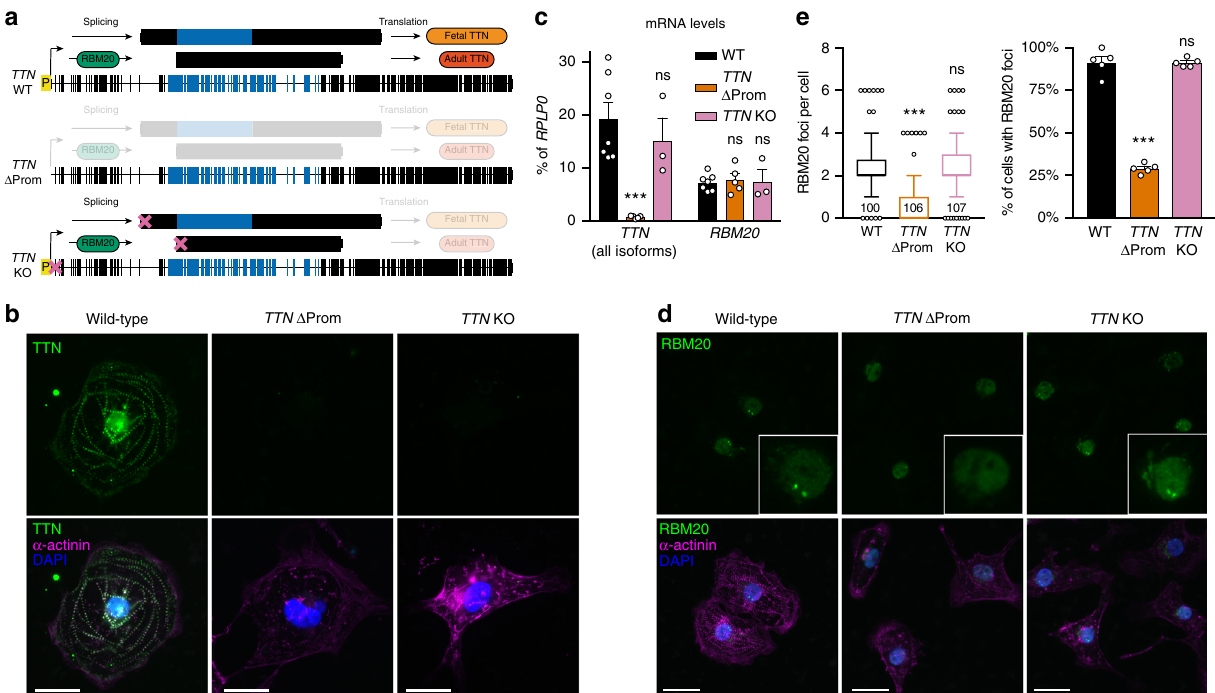
Fig. 8 TTN transcription is required for nucleation of RBM20 into foci. a Schematic of the hESC gene editing strategies used to test the role of transcription at the TTN locus. Δ Prom: promoter (P) deletion; KO: functional knockout by frameshift mutation (indicated by the X). Aspects of TTN biogenesis predicted to be impaired by each modi fi cation are indicated by increased transparency (loss of transcription following promoter deletion; loss of translation following knockout). Alternatively spliced exons regulated by RBM20 are shown in blue. b Representative immuno fl uorescence results in CM derived from the indicated hESC lines (nuclei counterstained with DAPI); scale bars: 10 µ m. c RT-qPCR in CM derived from the indicated hESC lines. Expression is relative to the housekeeping gene RPLP0 and mean ± s.e.m. is shown. n = 3, 5, or 7 independent differentiations for TTN KO, TTN Δ Prom, and WT, respectively. d As in panel ( b ); insets show magni fi ed views. e Quanti fi cation of RBM20 foci in CM derived from the indicated hESC lines. On the left, box and whiskers plots showing median, 25th and 75th percentile, and the 10 – 90 percentile range plus outliers; the number of cells is indicated (non-diploid CM were included in the analysis). On the right mean ± s.e.m.; n = 5 fi eld of views. All p -values in this fi gure are calculated vs WT by one-way ANOVA followed by Holm-Sidak ’ s multiple comparisons (for ( c ) and the right graph in ( e )) or by Kruskal – Wallis test followed by Dunn ’ s multiple comparisons (for the left graph in ( e )); ns ≥ 0.05; *** < 0.01. Source data are provided as a Source Data fi